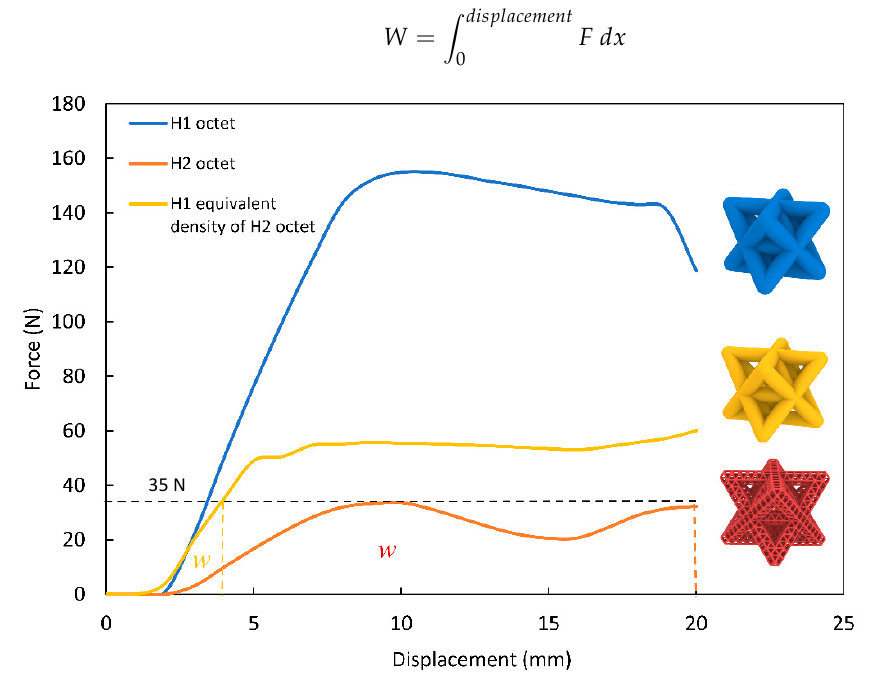
Figure 4. Compression behavior of 1st and 2nd order octet lattices.